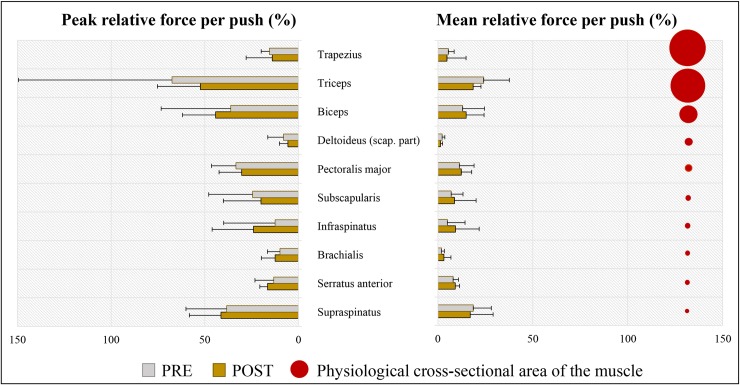
Relative peak and mean forces (N = 7) of individual muscles during the push phase for the pre- and the post-test.The proportional differences in the physiological cross-sectional area between the muscles are shown (right). Bars represent the median and the error bars represent the IQR. Only the muscles that had mean muscle forces during the push phase larger than 25 N are illustrated. The muscles are arranged in a descending order of physiological cross-sectional area.